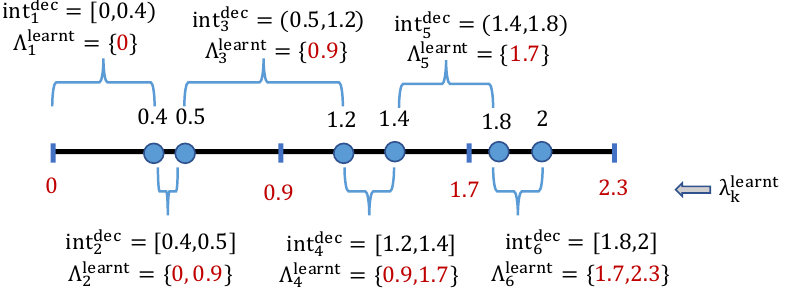
Figure 1. An example of discretizing λ learnt , Λ learnt = { 0,0.9,1.7,2.3 } , and the six resulting attacker sub-intervals and corresponding uncertainty sets, with λ max = 2, δ = 0.5. In particular, the first sub-interval of deceptive λ dec is int 1 = [ 0,0.4 ) in which any λ dec corresponds to the same uncertainty = { 0 } set of possible learning outcomes Λ learnt 1